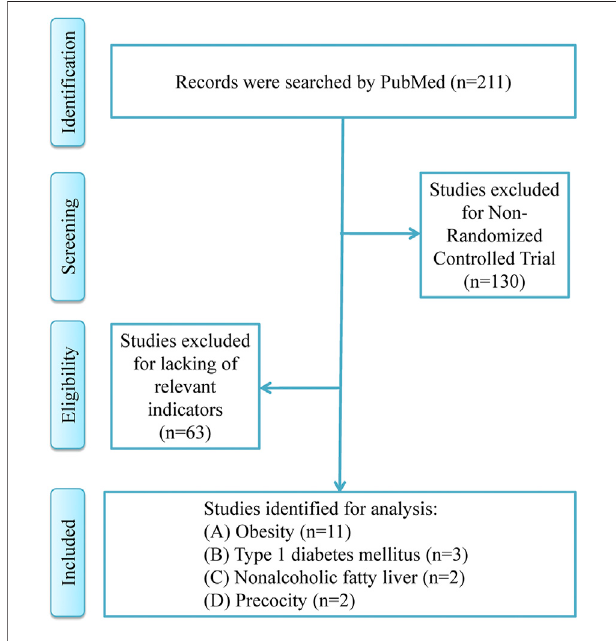
FIGURE 1 | Strategy for literature